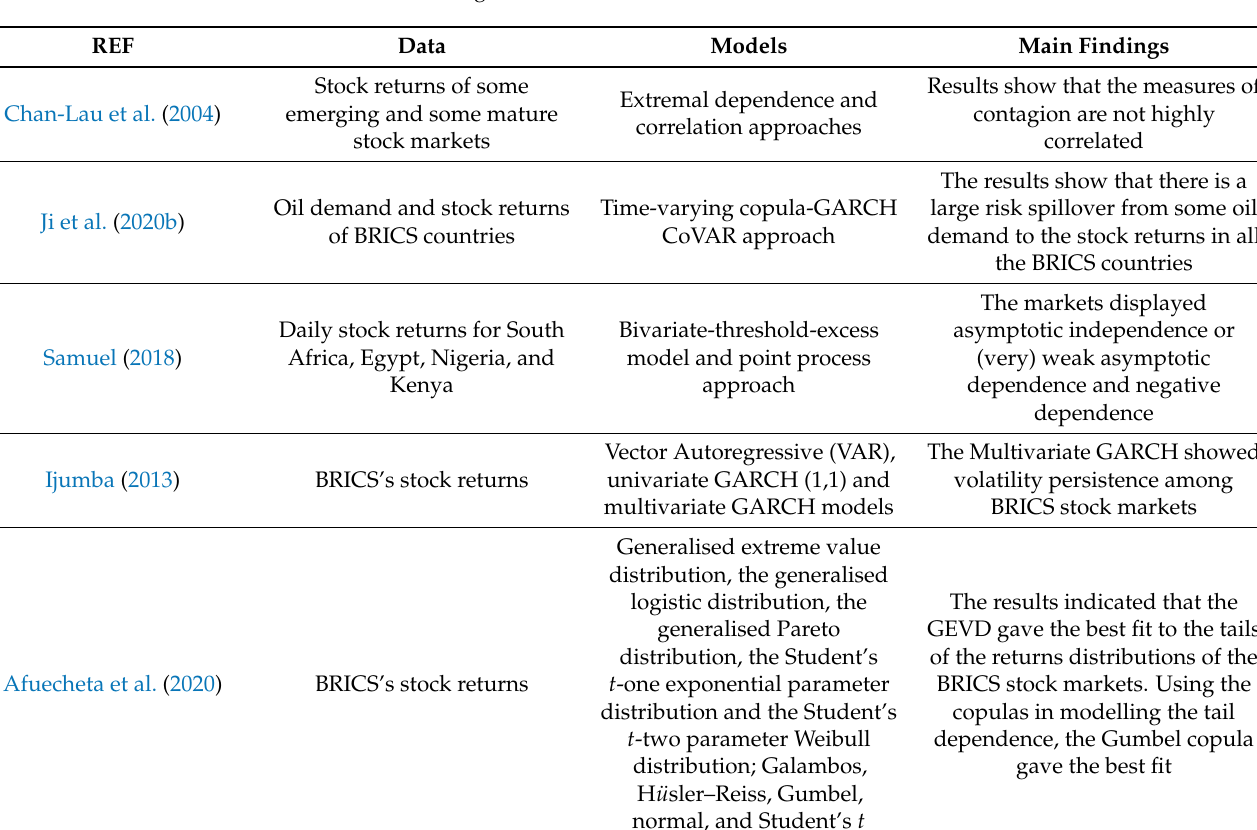
Table 1. Summary of previous studies on extremal dependence modelling of stock returns of BRICS countries including mature